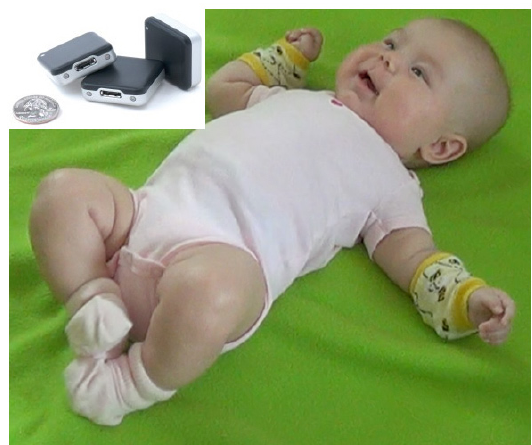
Figure 1. Infant wearing sensors on each arm. Inset: Three wearable sensors shown with a standard U.S. quarter dollar for